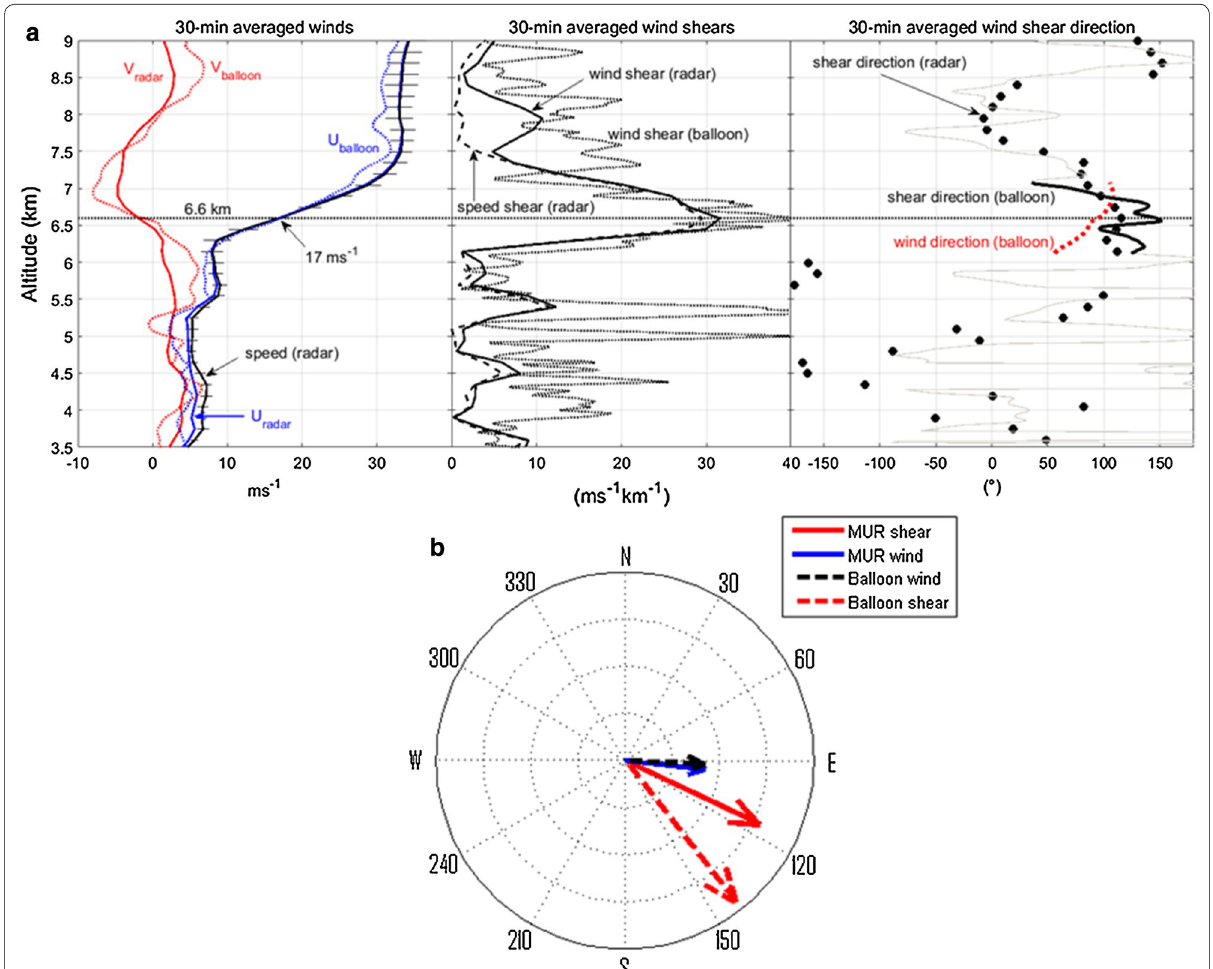
Fig. 5 a (Left) solid lines: MU radar-derived wind profiles averaged over 30 min (0557–0627 LT). Dotted lines: the corresponding profiles measured by the radiosonde about 1 h after. The altitudes are shifted upward by 0.5 km in order to compensate for the altitude variations of the frontal + layer. (Middle and right): the corresponding wind shears and wind shear directions. Circles are shear directions indicated by the MU radar. b Wind and shear vectors around the critical level according to the radar and balloon